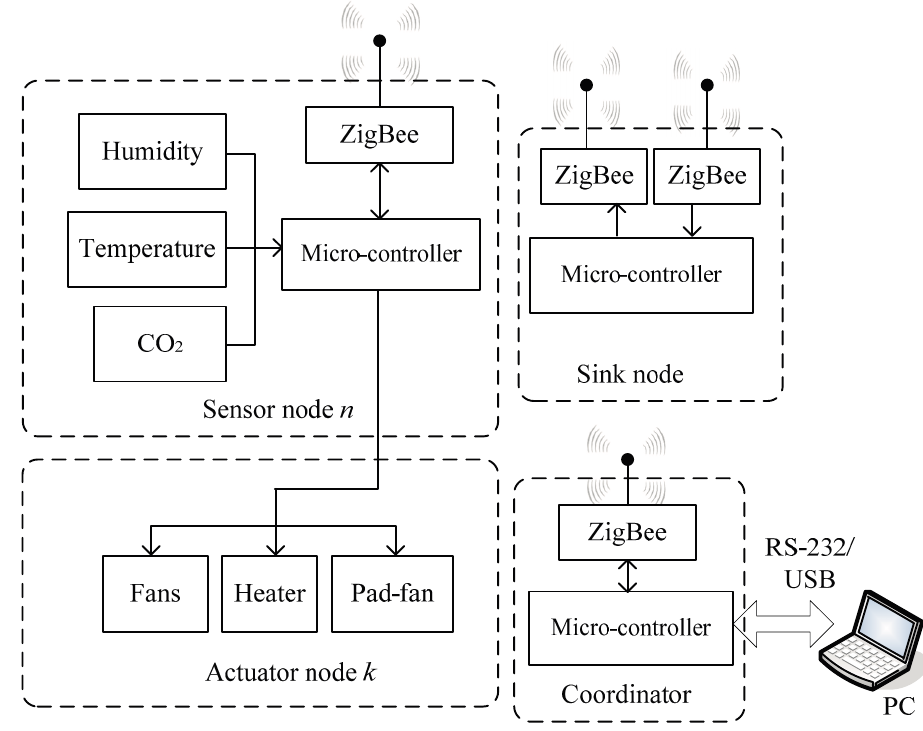
Figure 4. System structure with wireless sensor